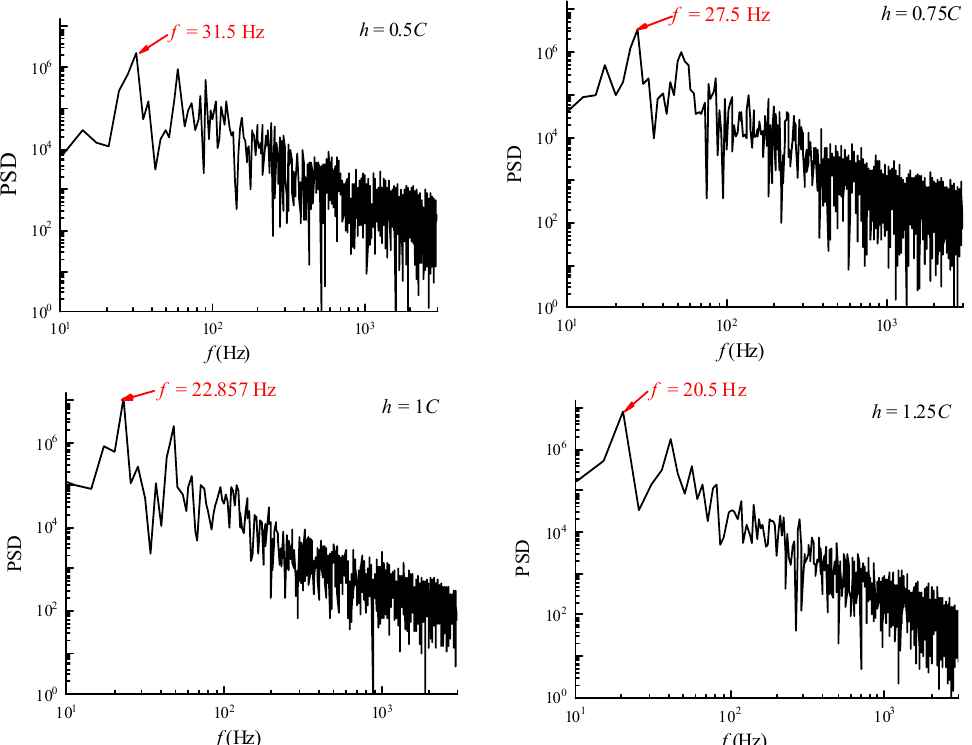
Figure 17. Comparison of the power spectral density of pressure fluctuations in different water depths.